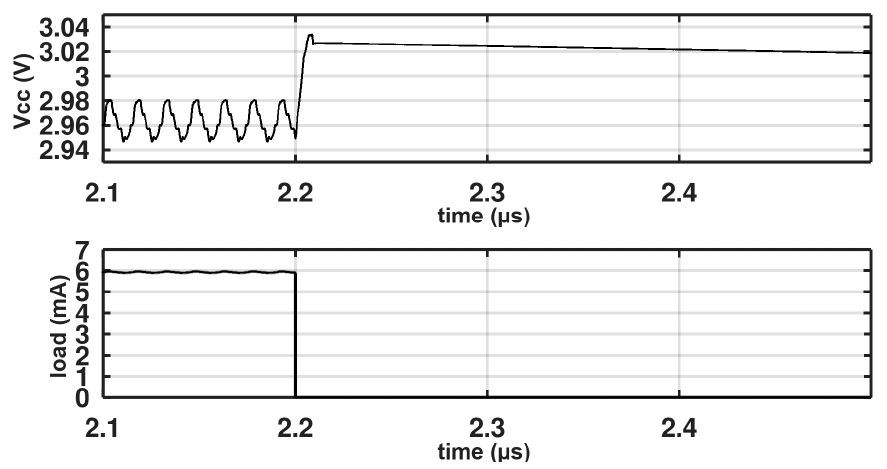
Figure 11. Transient response of the regulator when the load changes from 6 mA to 0 in 100 ps.